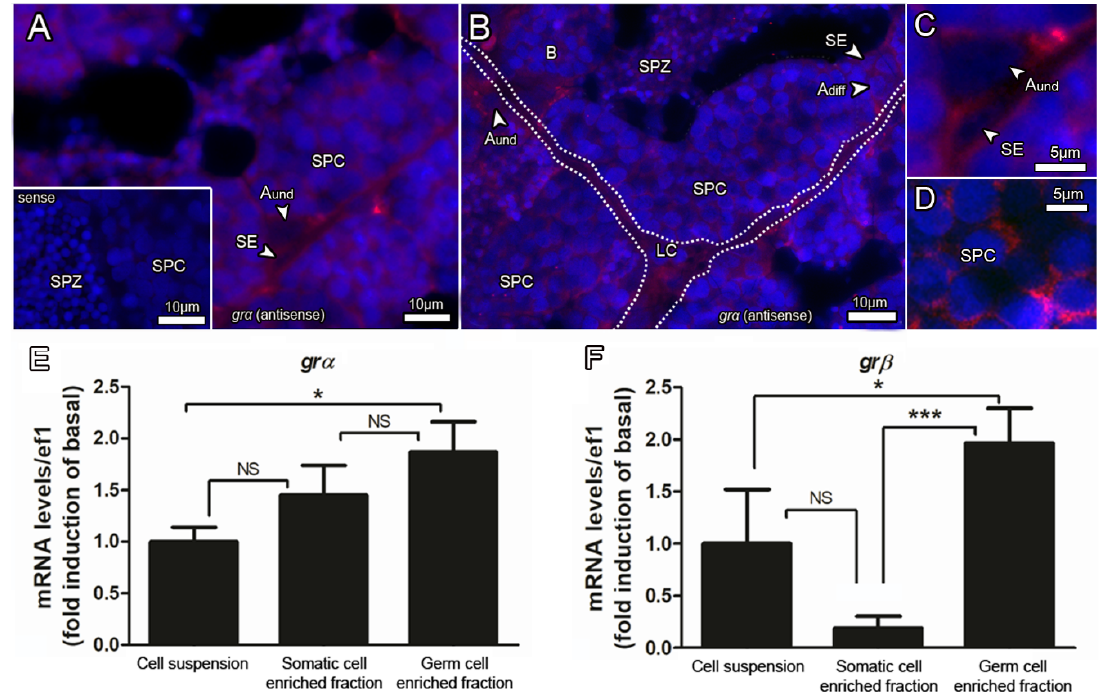
Figure 7. ( A – D ) Localization of gr α (glucocorticoid receptor alpha) expressing cells in the zebrafish testis. Sections were subjected to in situ hybridization using antisense cRNA probe, followed by a fluorescent detection system (HNPP / Fast Red kit (Roche)). The red fluorescence indicates presence of signal, while nuclei were counterstained with DAPI (blue). No specific staining was observed when sections were incubated with sense cRNA probes (inset in ( A )). gr α mRNA was detected in Sertoli cells (SE), Leydig cells (LC), and several types of germ cells. Type A undi ff erentiated spermatogonia (A und ); type A di ff erentiated spermatogonia (A di ff ); type B spermatogonia (B), spermatocytes (SPC) and spermatozoa (SPZ). The dashed lines delimitate the interstitial compartment. gr α ( E ) and gr β ( F ) in cell fractions (somatic and germ cell enriched cell fractions obtained from the di ff erential plate method) compared with the total testicular cell suspension. ANOVA followed by Student–Newman–Keuls; *** p < 0.001; * p < 0.05; NS = not significant.